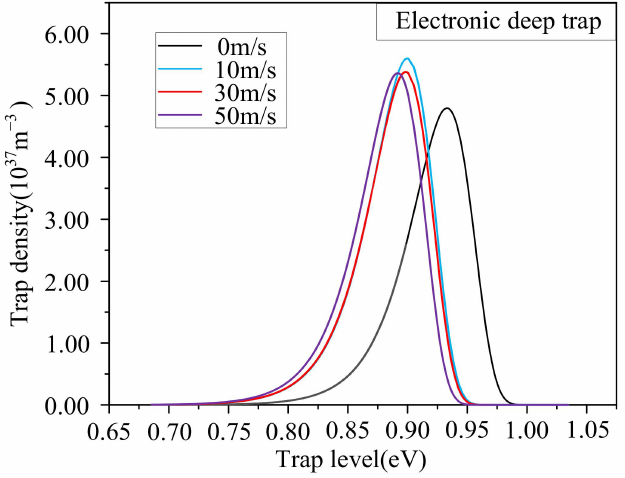
Figure 25. Distribution curve of deep trap density with trap energy level at different airflow velocities.